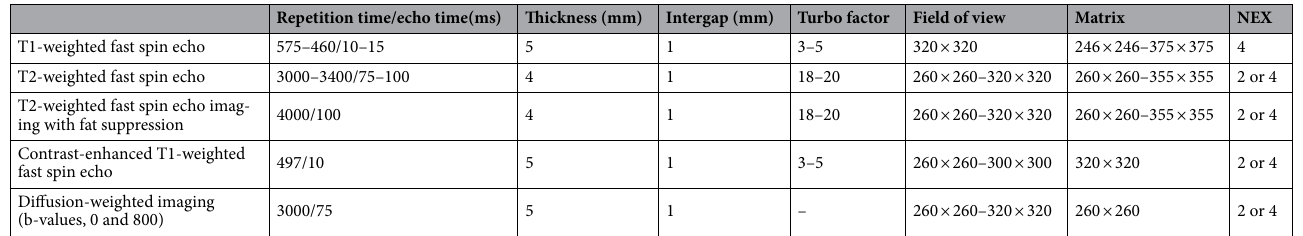
Table 4. Imaging parameters of sequences used in pregnancy-related